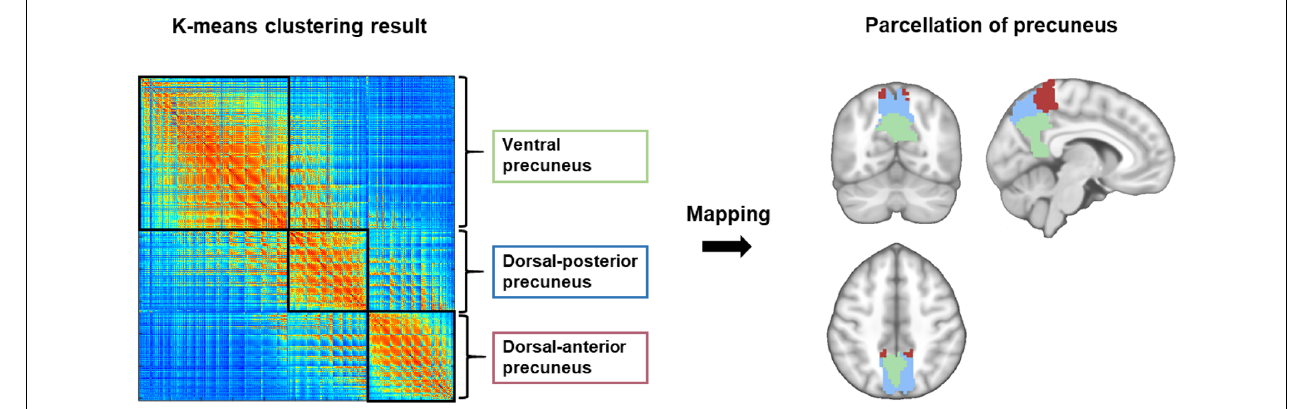
FIGURE 1 | Functional parcellation of the precuneus. Using the K-means clustering algorithm, the precuneus was subdivided into the dorsal anterior (red), dorsal posterior (blue) and ventral (green) subregions based on its intra-regional functional